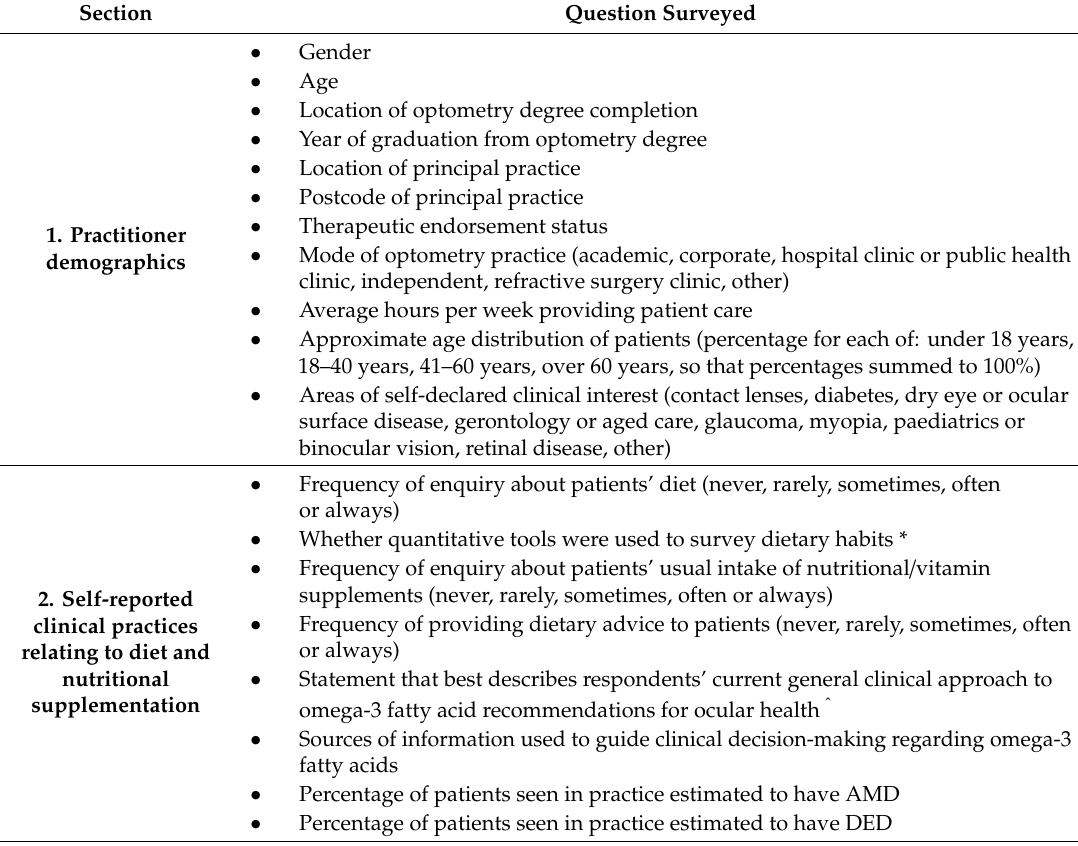
Table 1. Summary of survey